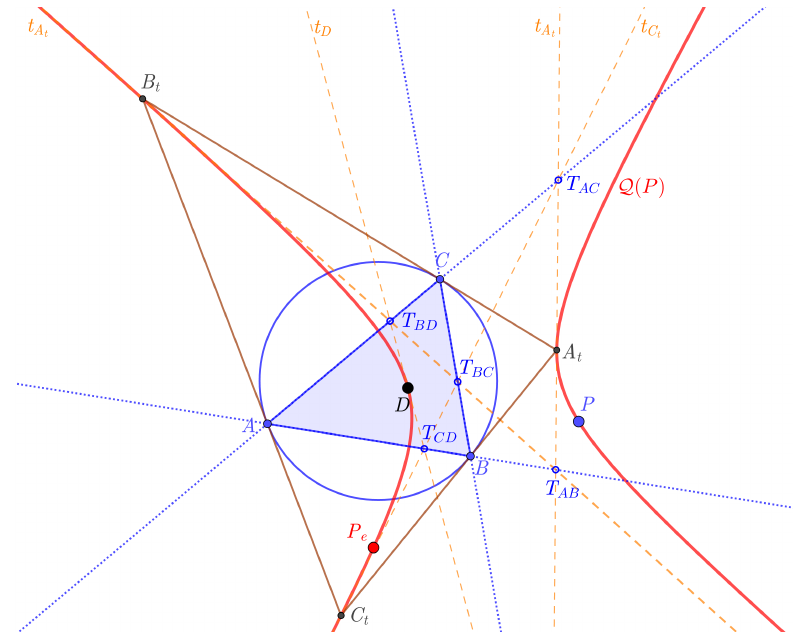
Figure 7. Tangent lines at points A t , B t , C t , and D